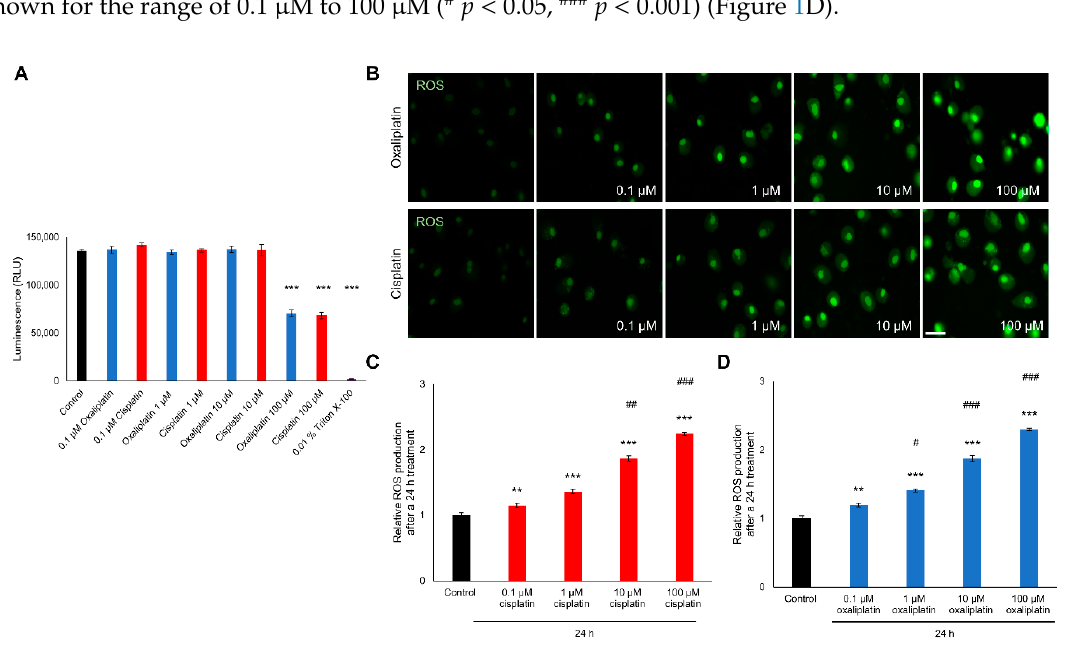
Figure 1. Viability and reactive oxygen species (ROS) production of cultured dorsal root ganglion (DRG) neurons after exposure to different concentrations of cis- or oxaliplatin for 24 h. ( A ) Viability of dorsal root ganglion (DRG) neurons was not affected by cis- or oxaliplatin exposure in a concentration of 0.1 µM, 1 µM, or 10 µM for 24 h, compared to untreated control neurons ( p > 0.05). Exposure to 100 µM cis- or oxaliplatin or to 0.01% Triton X-100 reduced viability of DRG neurons after 24 h (*** p < 0.001). ( B ) Fluorescence of CellRox (green) in DRG neurons exposed to different concentrations of cis- or oxaliplatin for 24 h. ( C ) Reactive oxygen species (ROS) production of DRG neurons was increased by cisplatin exposure after 24 h (** p < 0.01, *** p < 0.001), compared to untreated control neurons. A concentration-dependent effect was observed for the range of 1 µM to 100 µM ( ## p < 0.01, ### p < 0.001). ( D ) Exposure of DRG neurons to different concentrations of oxaliplatin increased ROS production as well (** p < 0.01, *** p < 0.001). A concentration-dependent effect was observed for the range of 0.1 µM–100 µM ( # p < 0.05, ### p < 0.001). n ≥ 200 cells per condition for ROS measurement. n = 3 independent experiments per condition. * = significant effect compared to control condition. # =